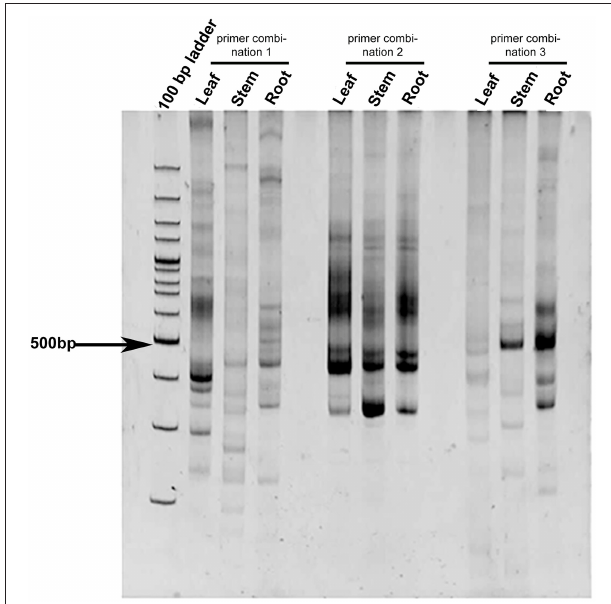
FIGURE 1 | Differential expression profile of CYP450 in C. forskohlii . The study was carried out in different tissues (leaf, stem, and root) of C. forskohlii using different degenerate primer combinations (designed from conserved domains of CYP450).